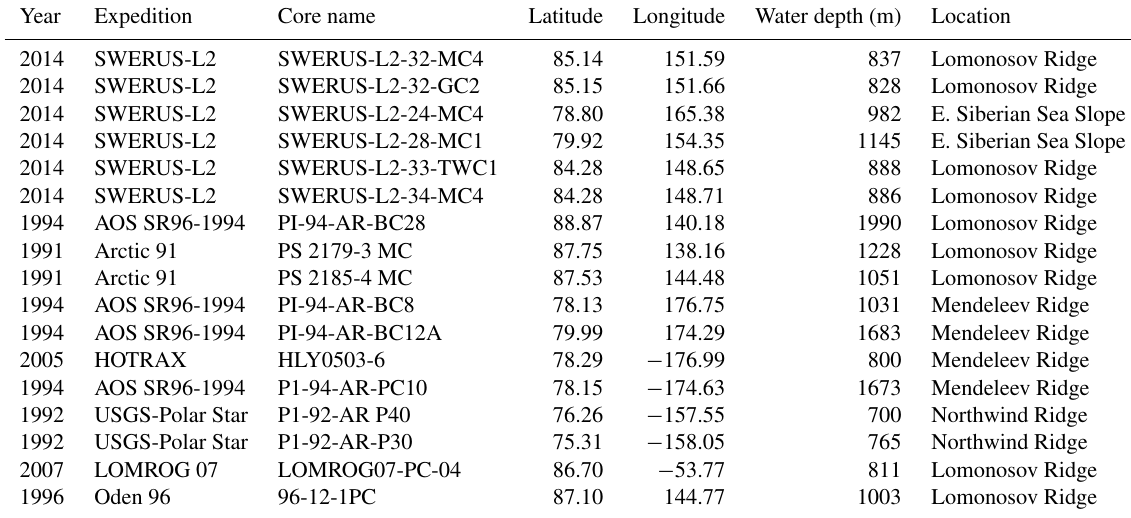
Table 1. Expedition and core site data for cores presented in this